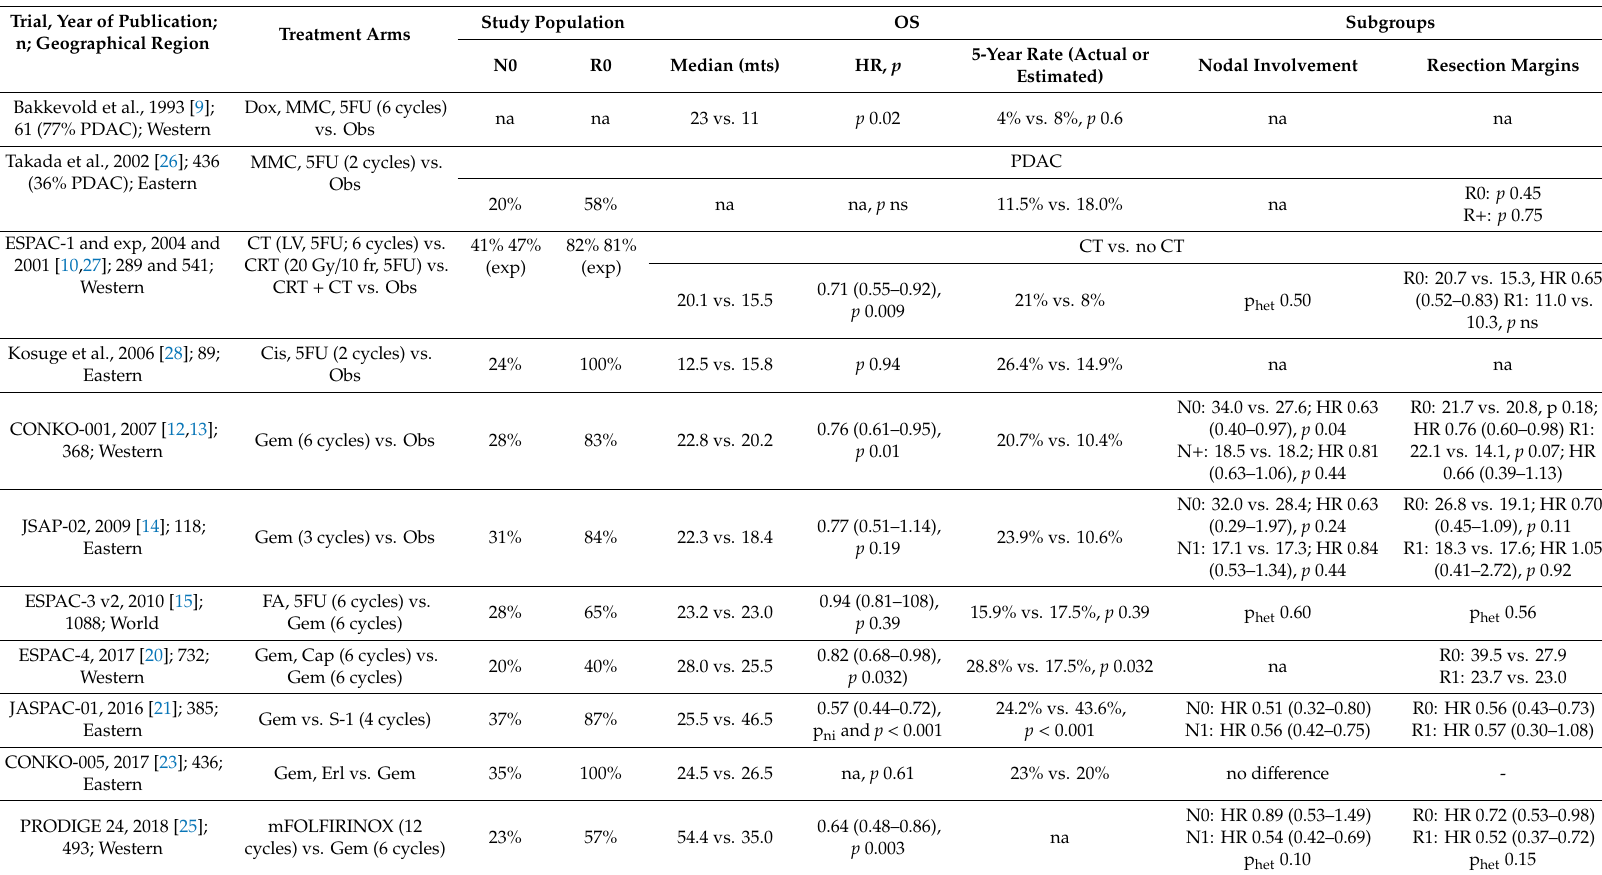
Table 1. OS outcomes of the published randomized, controlled trials of adjuvant CT in